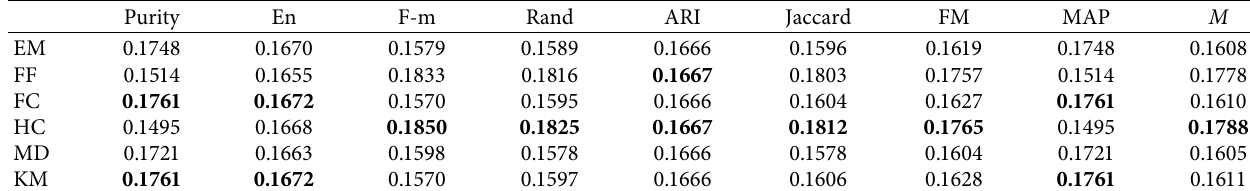
Table 4: Standardized values of the nine external measures for the Ionosphere data set.